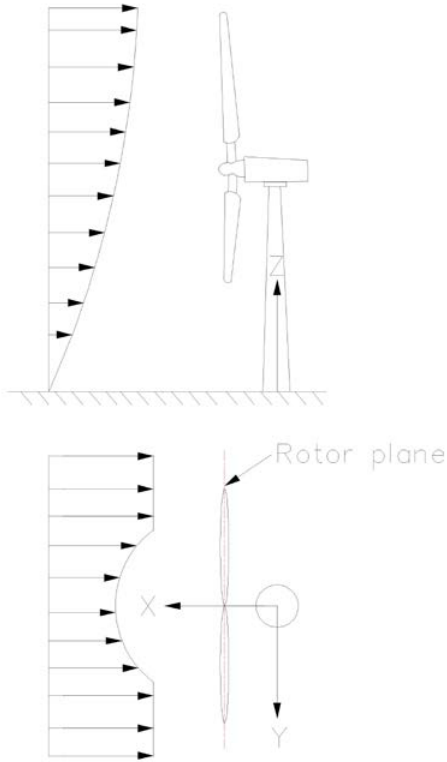
Figure 1. The wind shear and tower shadow effect of wind turbines.